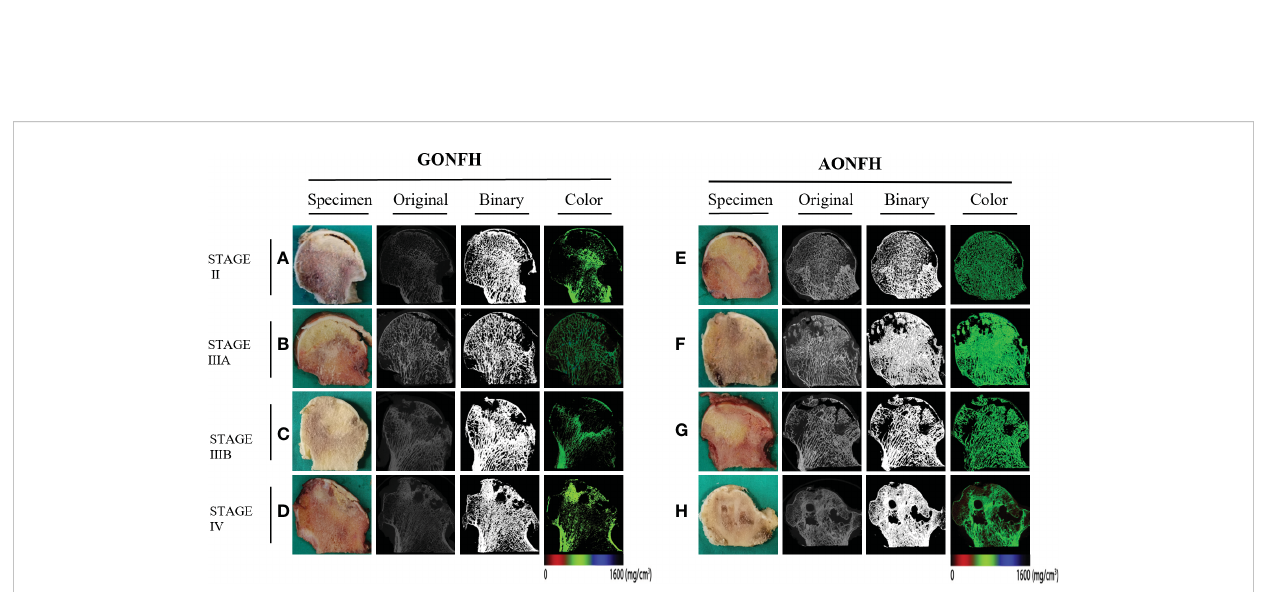
FIGURE 3 Representative original, binary and color micro-CT images corresponding to the coronally sectioned gross specimen of the femoral head from patients with GONFH (A-D) and patients with AONFH (E-H) . (A, E) ARCO stage II. (B, F) ARCO stage IIIA. (C, G) ARCO stage IIIB. (D, H) ARCO stage IV. Note: The color images represented mineralization distribution in trabecular bone. Red, green and blue represent low, intermediate and high mineral density, respectively.